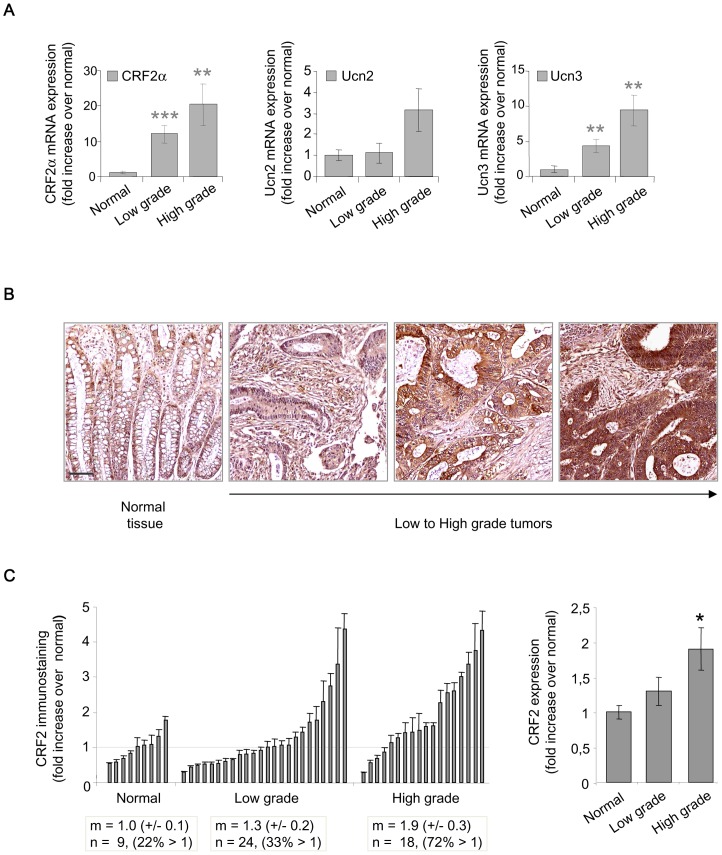
CRF2 and ligand expression are increased in high grade and poorly differentiated human CRC.(A) Histograms representing CRF2α, Ucn2 and Ucn3 transcript expression normalized to the housekeeping gene PGK (phosphoglycerate kinase) in human normal tissues or CRC (low and high grades). (B) Representative CRF2 immunohistochemistry performed on CRC tissues from low to high grade. Scale bar, 50 µm. (C) Histograms representing CRF2 protein expression quantified from immunohistochemistry. Each sample is represented as dark bars +/− SD (left) and the mean value of each group +/− SD (right). High grade is statistically different from normal at *, p<0.05.